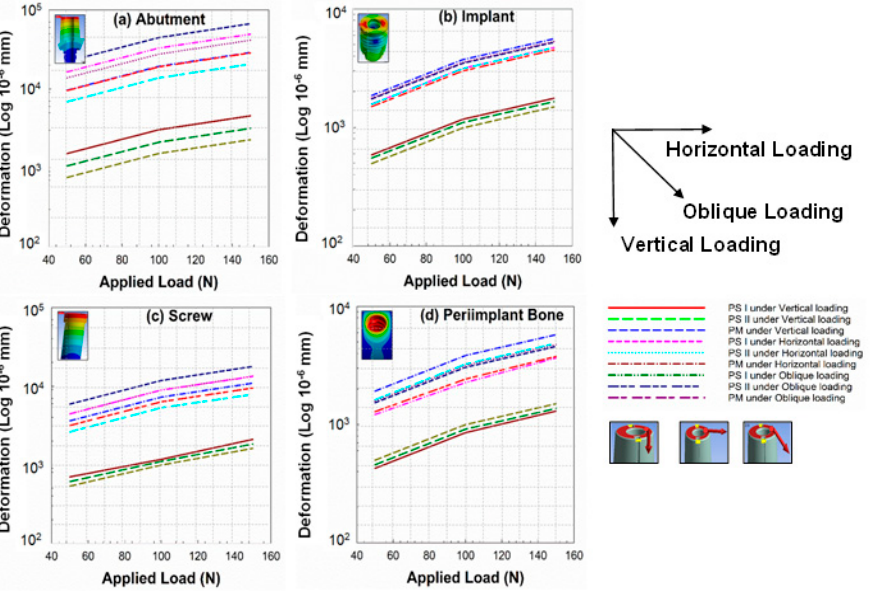
Figure 7. Graphs representing deformation analysis of ( a ) abutment, ( b ) implant, ( c ) screw, and ( d ) peri-implant bone for PS I, PS II, and PM configuration under different loading conditions.